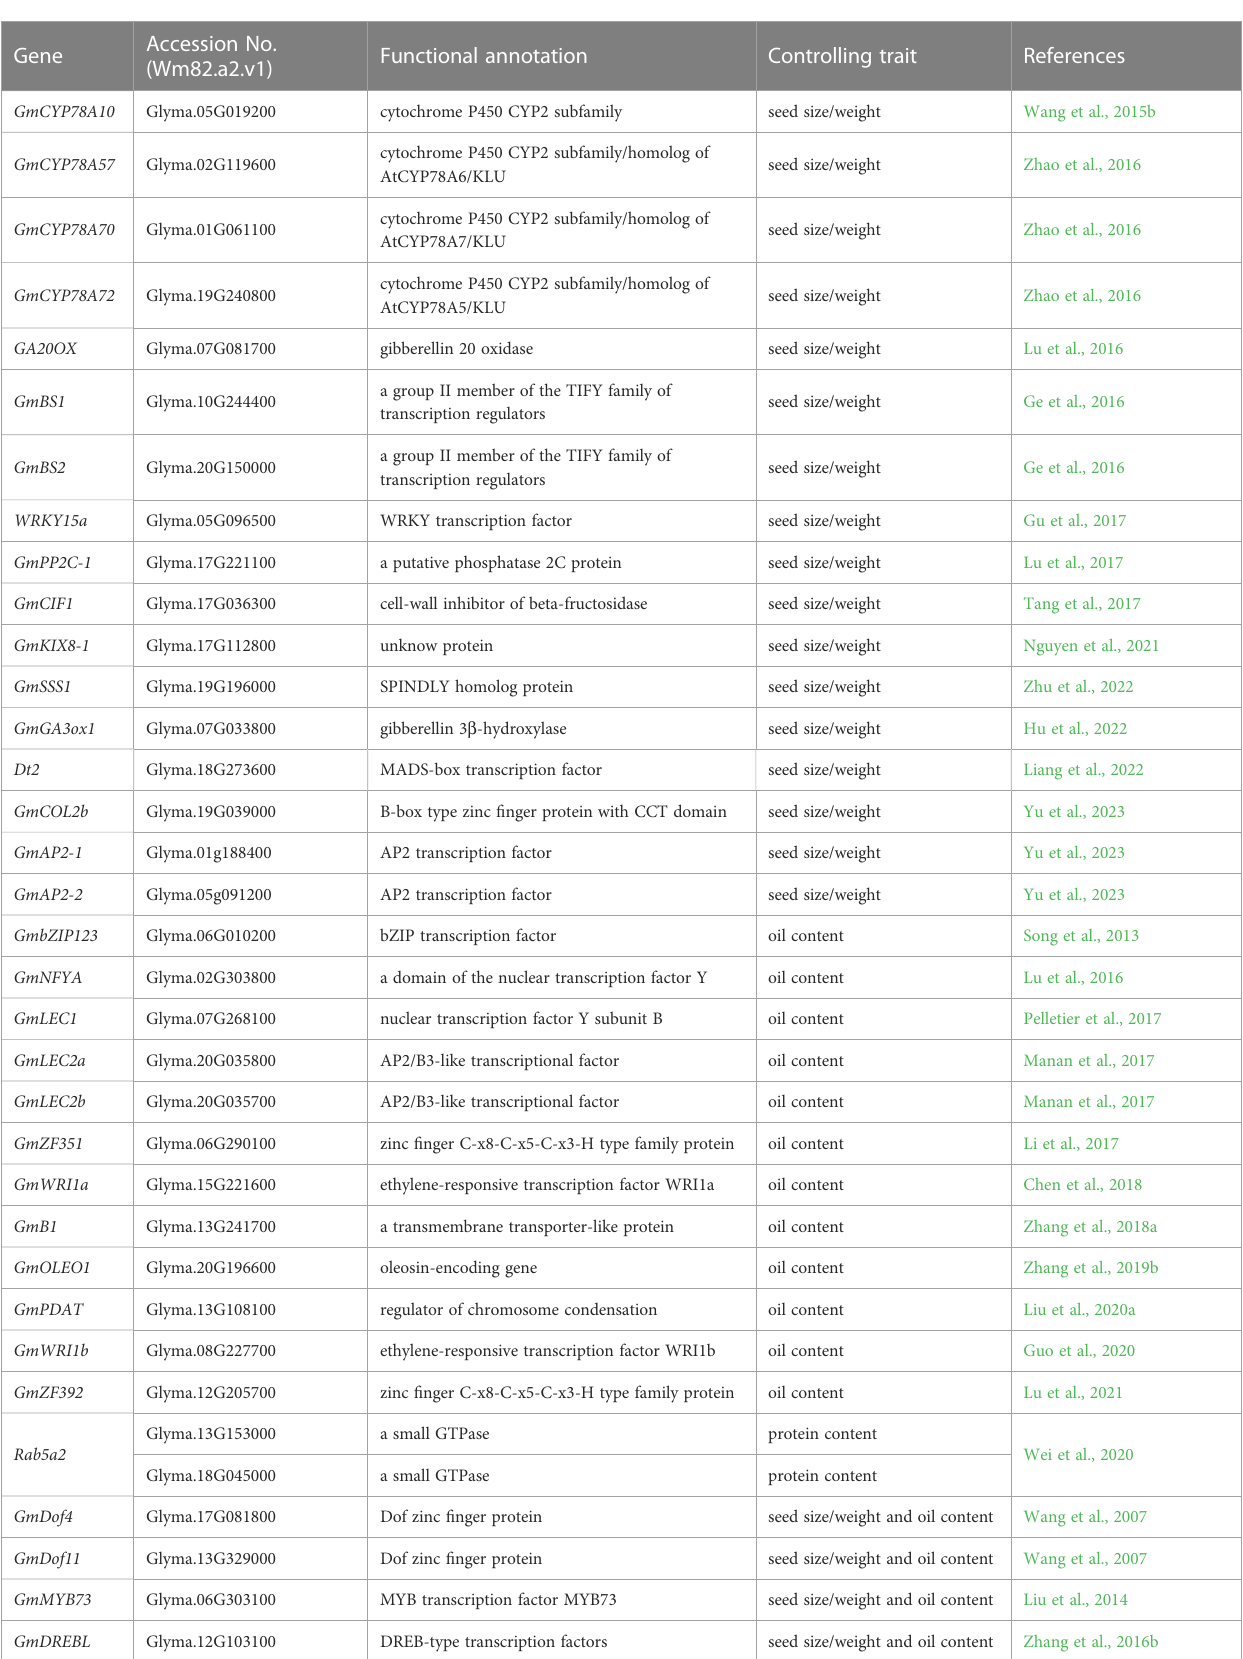
TABLE 1 Representative genes related to seed size, oil accumulation, and protein content in